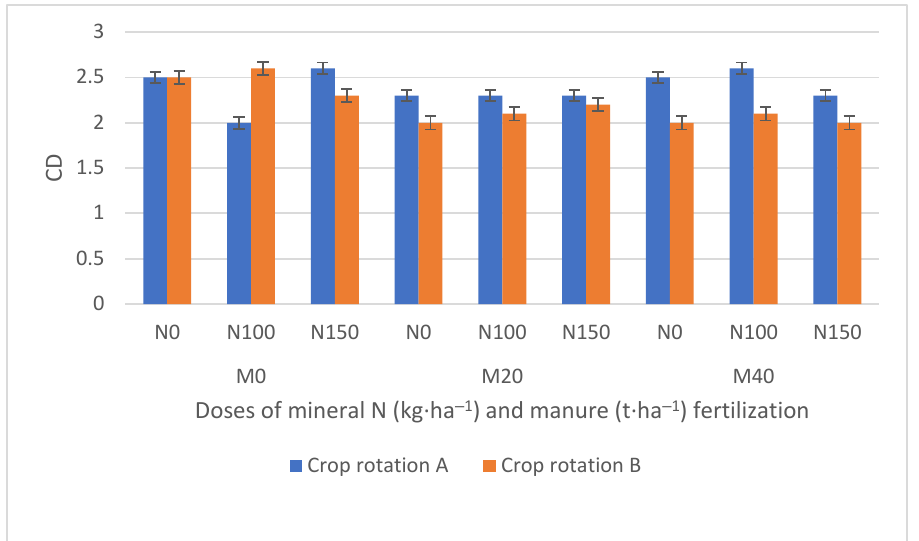
Figure 6. Carbon in extracts after soil decalcification (CD) contents in in the topsoil layer (0–30 cm) as influenced by crop rotation (I), manure application (II) and inorganic N rate (III) in the long-term field experiment at Grabow, Poland. Error bars denote standard deviations ( n = 3). LSD ( p ≤ 0.05): for I = 0.088, II = 0.07. C = n.s., II/I = 0.104, I/II = 0.120, III/I = 0.087, I/III = 0.109, III/II = 0.106, II/III = 0.113.